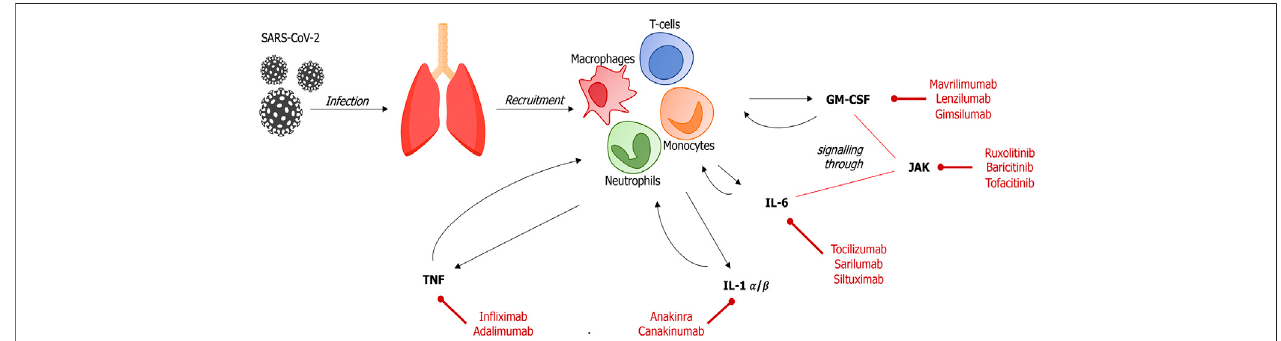
FIGURE 1 | Main pathways and treatment targets in SARS-CoV-2 – induced immune response In the early stage of SARS-CoV-2 infection, infected cells and residentmacrophagesreleasesignalingmoleculesthatrecruithostimmunecellsintothealveolarspace.Thesecells,mainlyneutrophils,T-lymphocytesandmonocytes, produce and release high levels of in fl ammatory cytokines, leading to an uncontrolled in fl ammatory response (GM-CSM, granulocyte-monocyte colony-stimulating factor; IL, interleukin; JAK, Janus kinase; TNF, tumor necrosis factor).